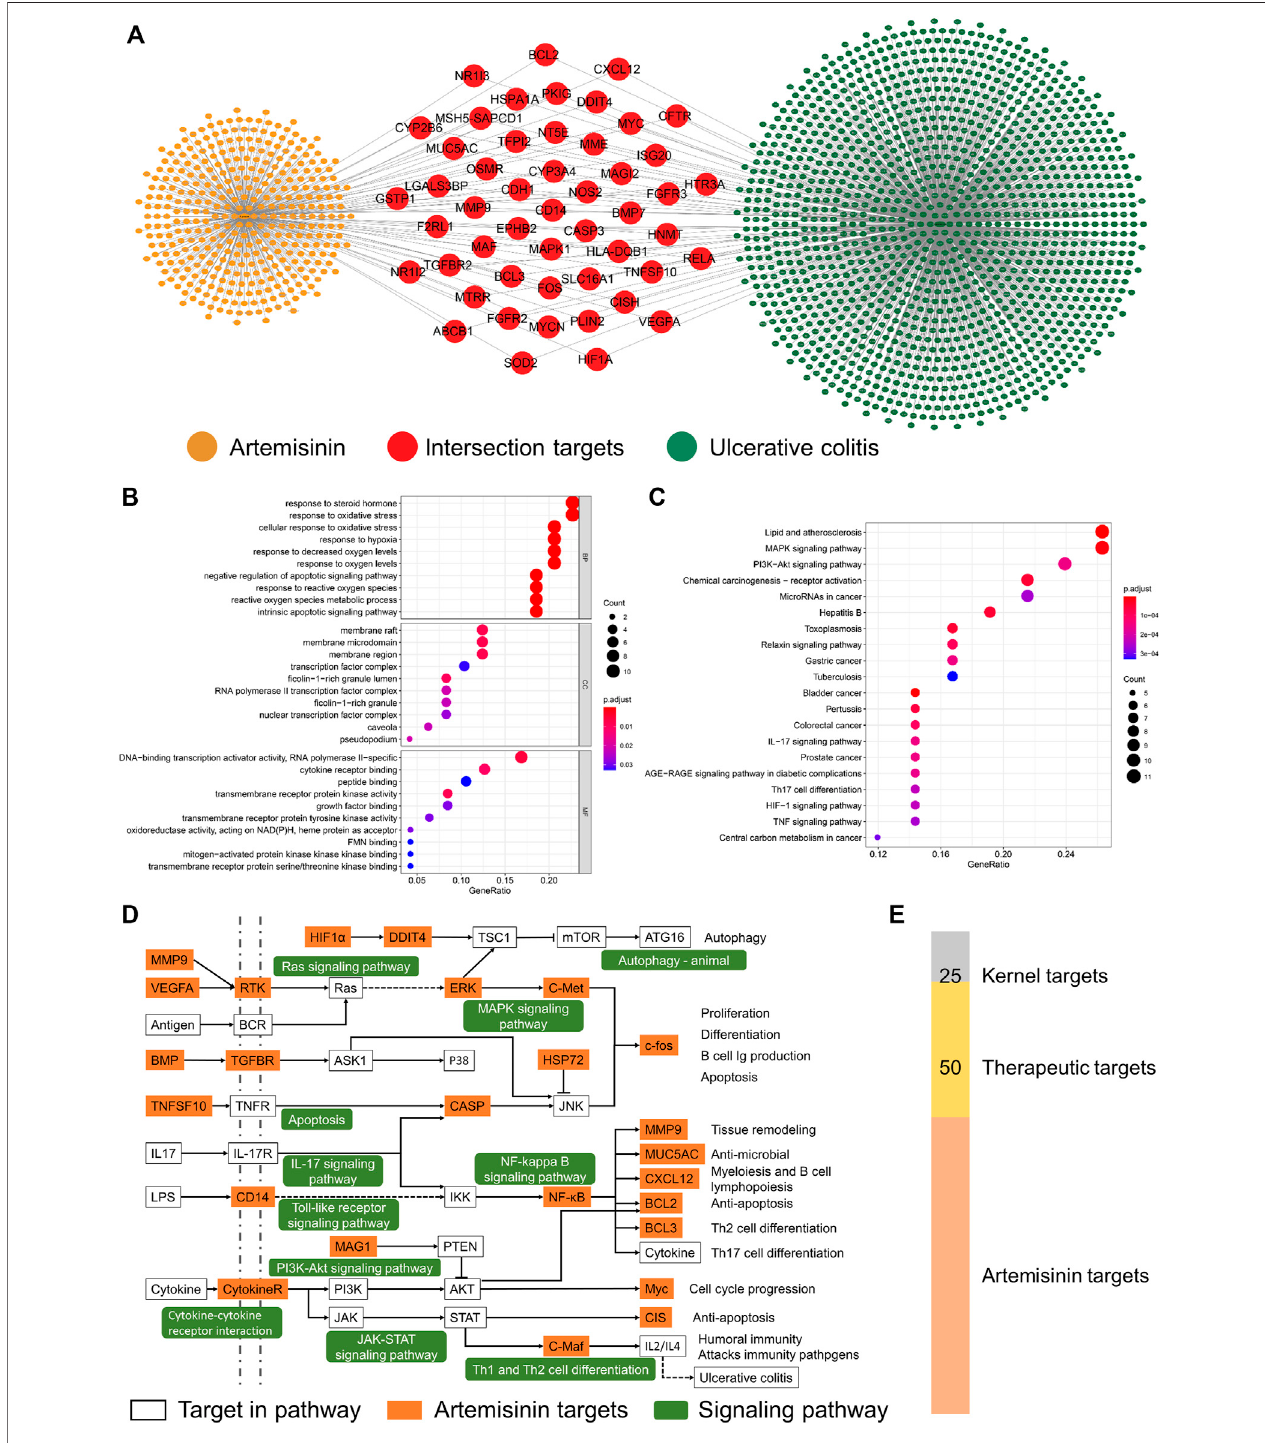
FIGURE 1 | Potential biological mechanism of artemisinin in the treatment of ulcerative colitis. (A) Artemisinin-UC network. (B,C) The potential biological mechanismandpathwayofartemisinininthetreatmentofUC. (D) ThetherapeuticpathwayofartemisinininthetreatmentofUC. (E) Thescreenednumberoftherapeutic